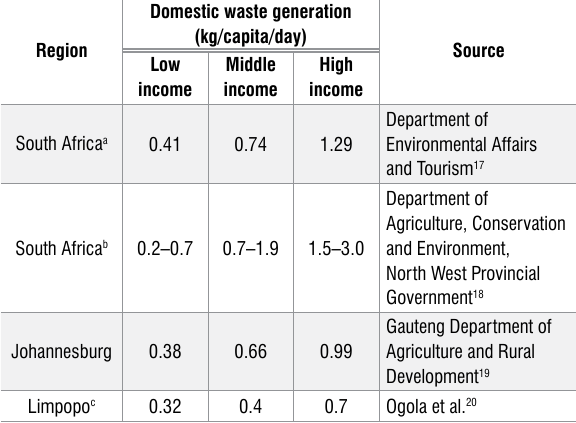
Table 3: Per capita domestic waste generation rates in South Africa